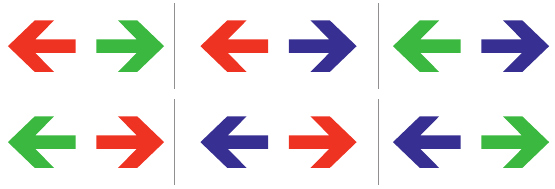
Figure 5: Arrow color map used in the experiment.